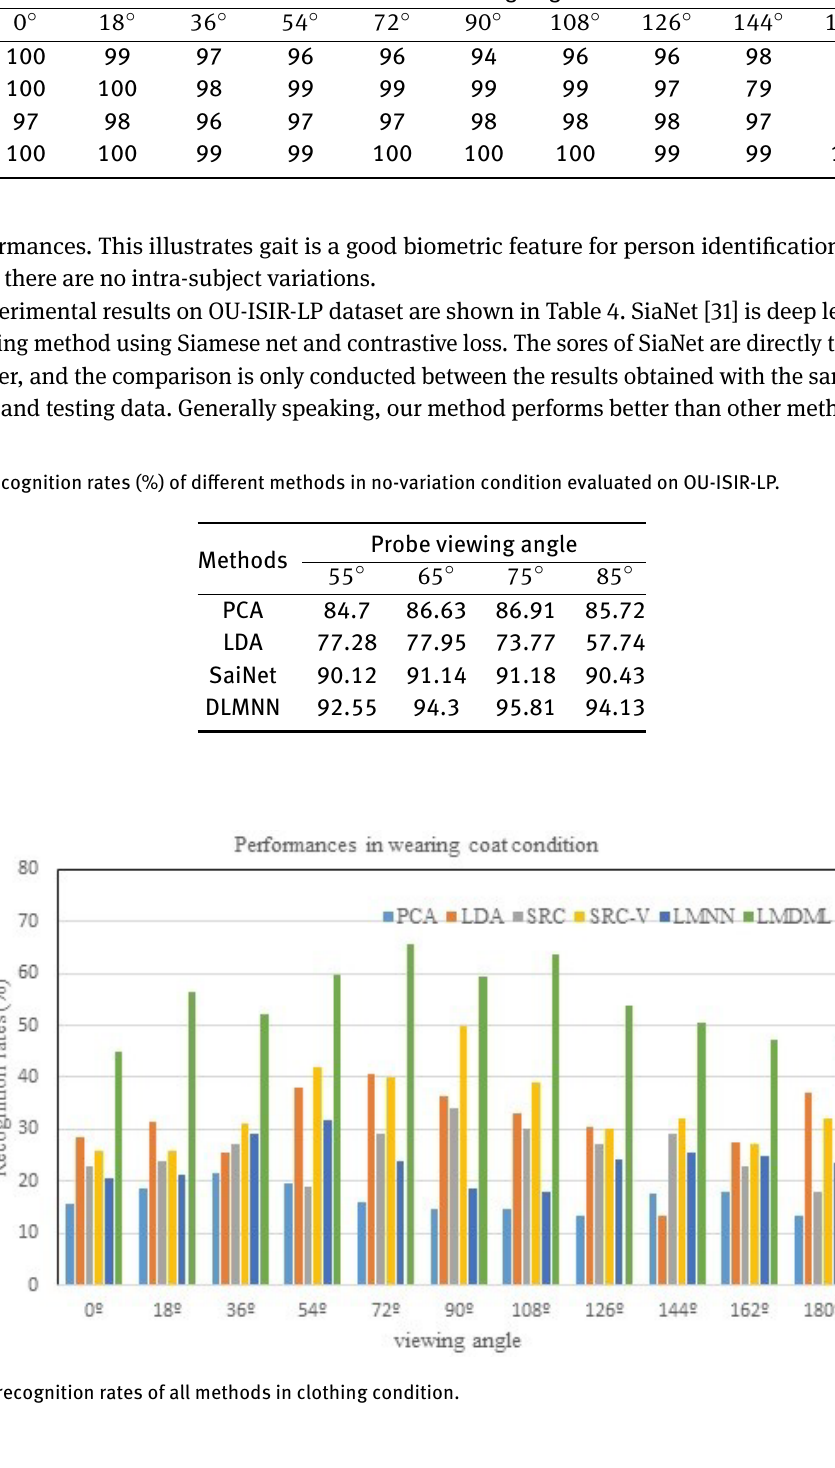
Figure 9: The recognition rates of all methods in clothing